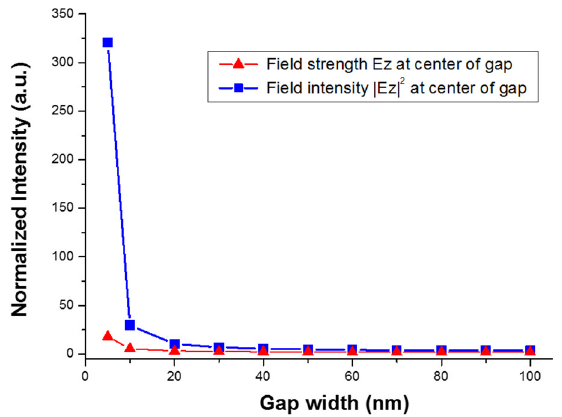
Figure 10. Schematic illustration of the structure for simulation. ( a ) Laser excitation and idealized silver islands as metal–insulator–metal (MIM) nanostructure. ( b ) Coordinate definition in the simulation. ( c ) Schematic diagram of the MIM structure in 2D.